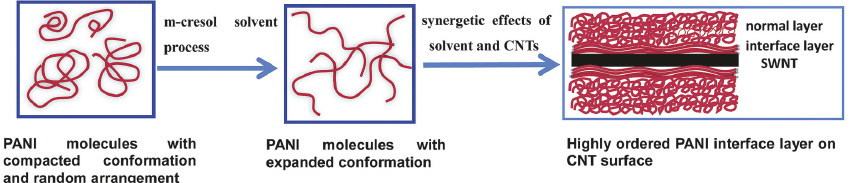
Figure 14: Schematics showing the process for forming ordered PANI interface layer by the synergistic effects of the solvent process and the 𝜋 – 𝜋 conjugation between PANI and CNTs. Figure is reproduced with permission